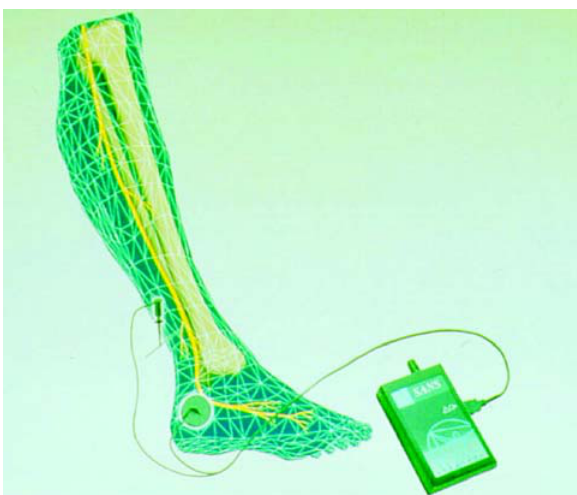
Figure 7 – SANS device for percutaneous